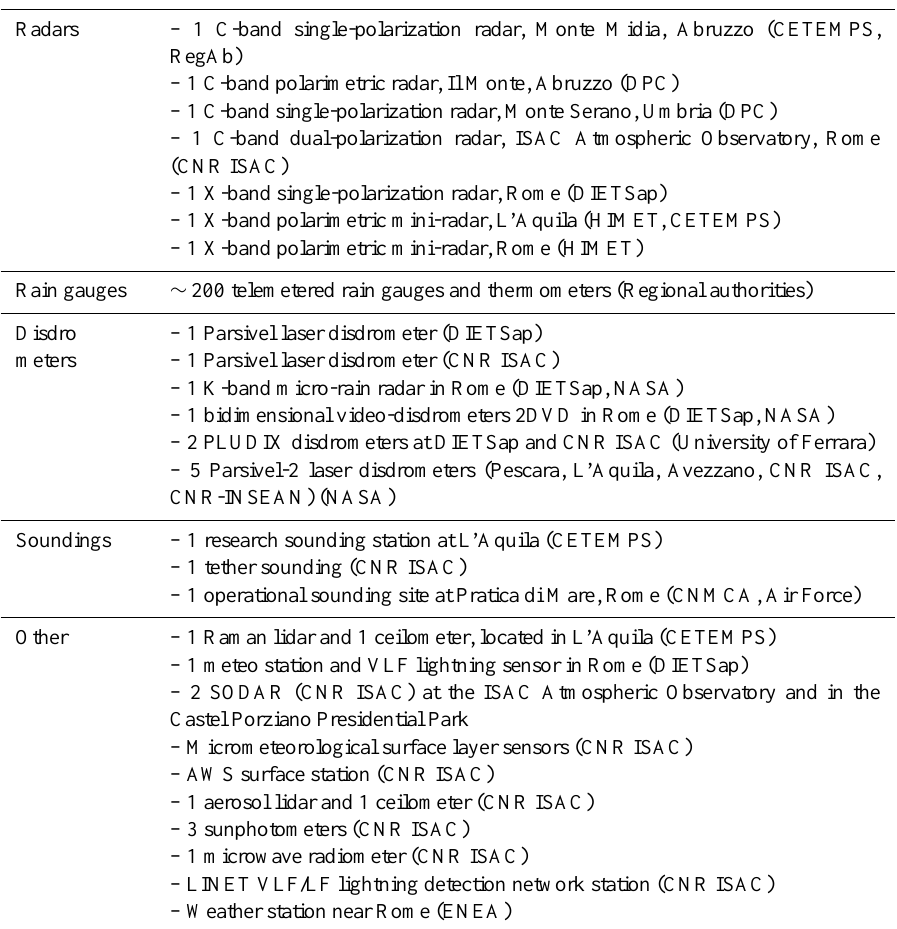
Table 1. Instrumentation deployed over the CI area during SOP1 (in parentheses the responsible institutions).